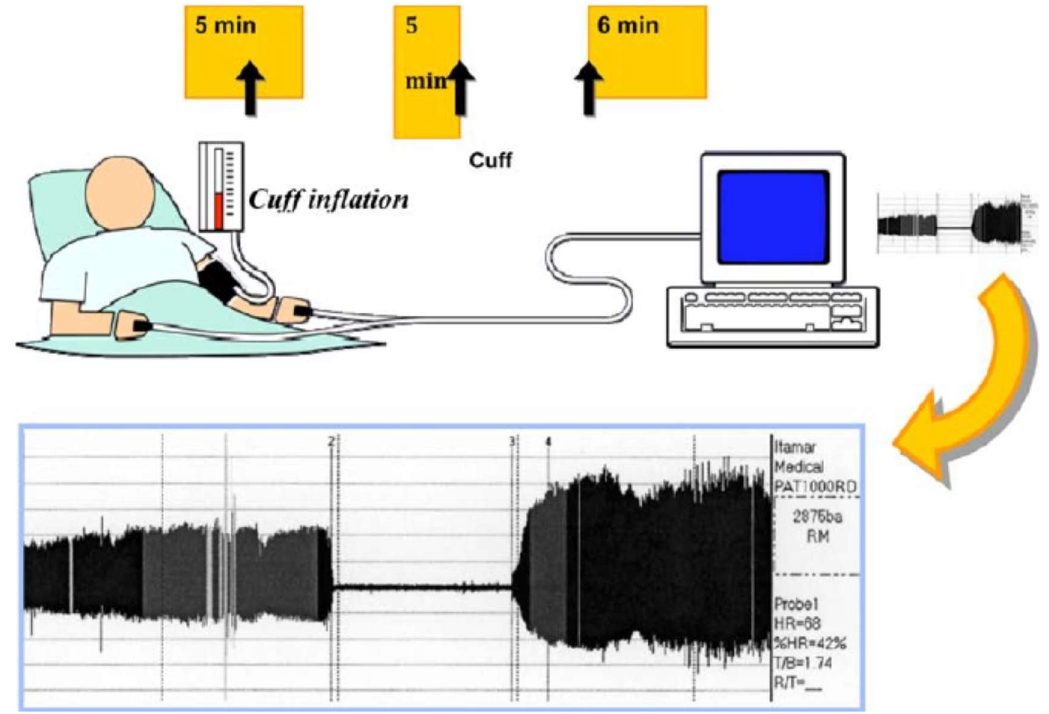
Figure 2. Illustration of the method of peripheral arterial tonometry. Modified from [40].